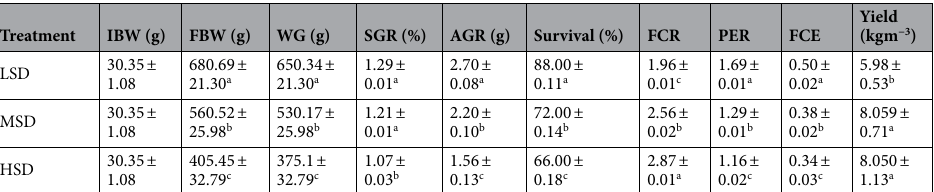
Table 1. Growth performance and feed utilization efficiency of L. rohita stocked at three different stocking densities. Values are mean ± SE. Means in the same column within each classification bearing different superscripts (a, b, c) are significantly different ( P < 0.05). IBW initial body weight, FBW final body weight, WG weight gain, SGR specific growth rate, AGR absolute growth rate, FCR feed conversion ratio, PER